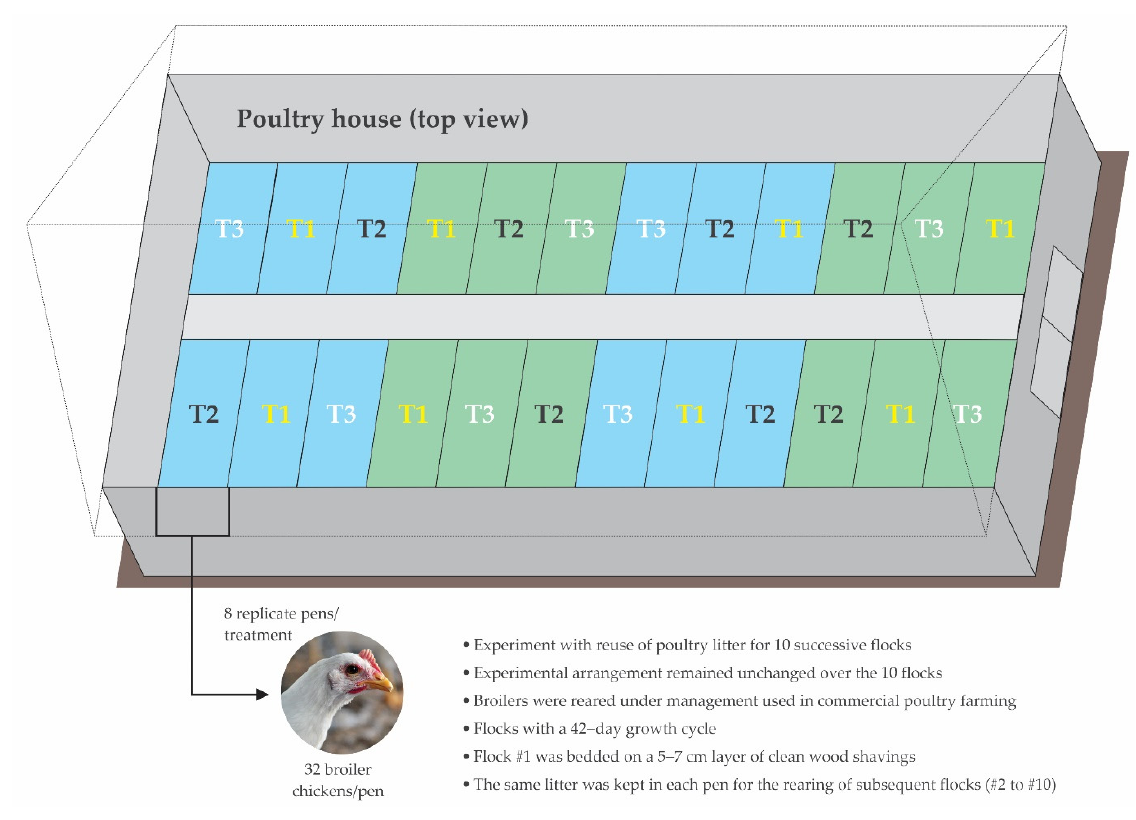
Figure 1. Schematic illustration of experimental setup.